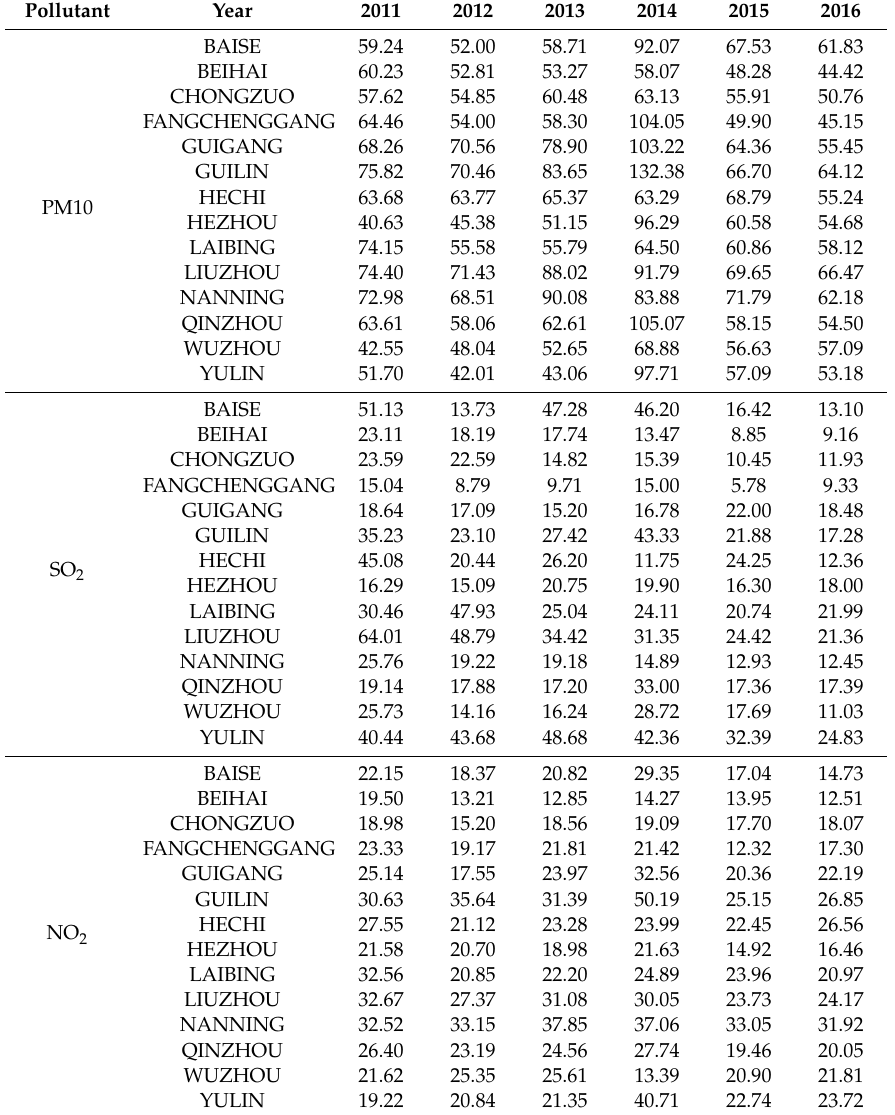
Table 2. Annual average concentration of air pollutants of 14 municipal cities in Guangxi (10 µ g / m 3 ).